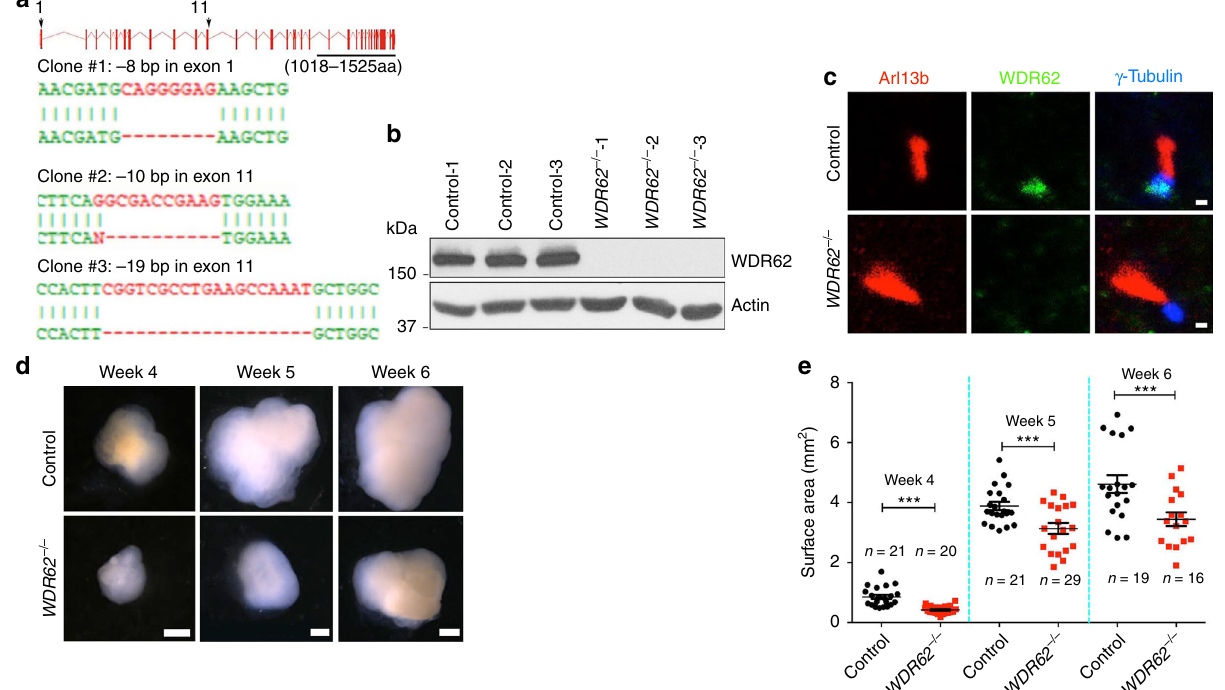
Fig. 1 WDR62 deletion results in smaller cerebral organoid sizes. a , b CRISPR/Cas9-mediated gene editing of human WDR62 locus in pluripotent stem cells (PSCs), resulting in 8 bp depletion in exon 1, and 10 or 19 bp deletion in exon 11 ( a ). All of them resulted in ablation of WDR62 proteins due to premature mature stop codons ( b ). c Confocal imaging of control and mutant PSC-derived NPCs stained with antibodies against Arl13b (red), WDR62 (green), and γ -Tubulin (blue). Scale bars: 0.5 μ m. d Representative images of control and WDR62 − / − cerebral organoids at week 4, 5, and 6. Scale bars: 1 mm. e Quanti fi cation of surface areas of cerebral organoids. Error bars represent SEM of three independent experiments containing numbers of organoids as indicated; *** P < 0.001 (Student ’ s t